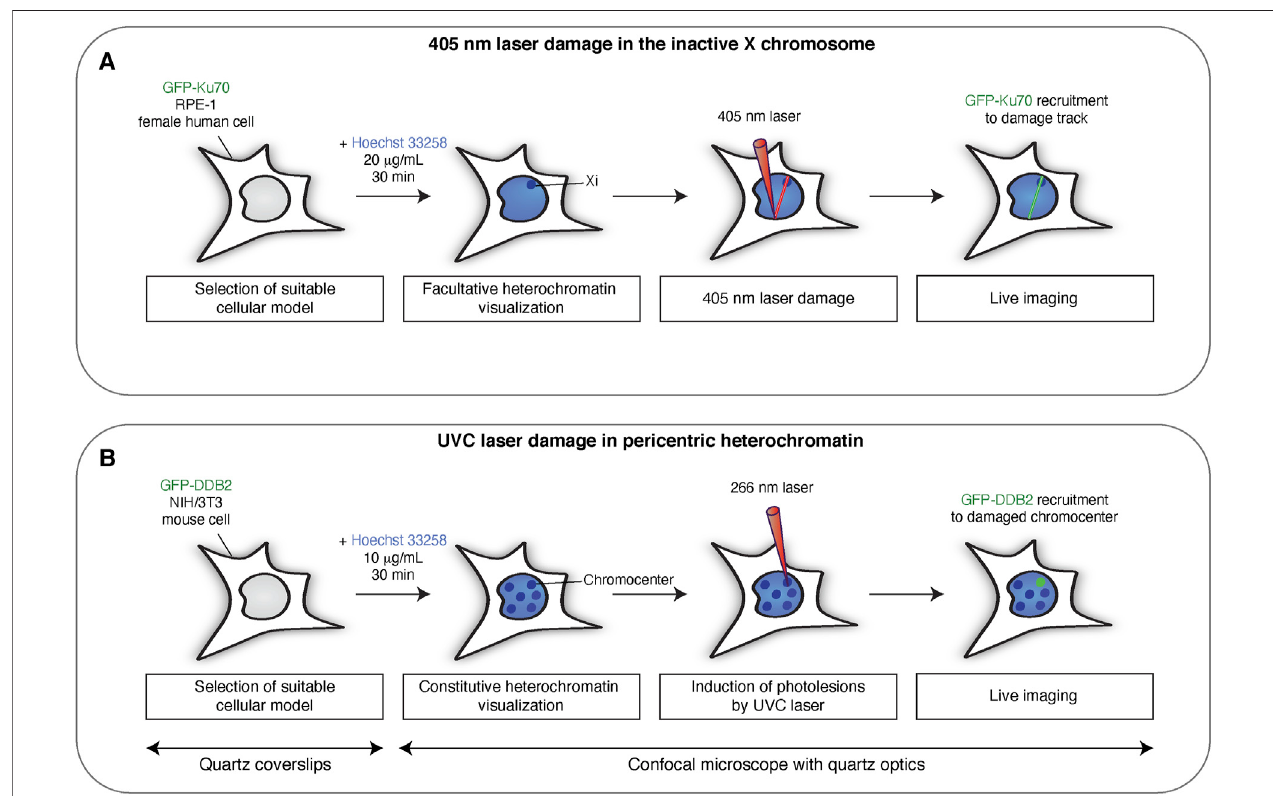
FIGURE 1 | Targeting DNA damage to heterochromatin domains in mammalian cells with laser micro-irradiation. Scheme illustrating the main steps for inducing DNA damage in the inactive X-chromosome (Xi) by 405 nm laser micro-irradiation (A) and in pericentric heterochromatin by UVC laser micro-irradiation (B) . UVC micro- irradiation requires quartz coverslips and quartz optics since UVC light does not penetrate conventional glass